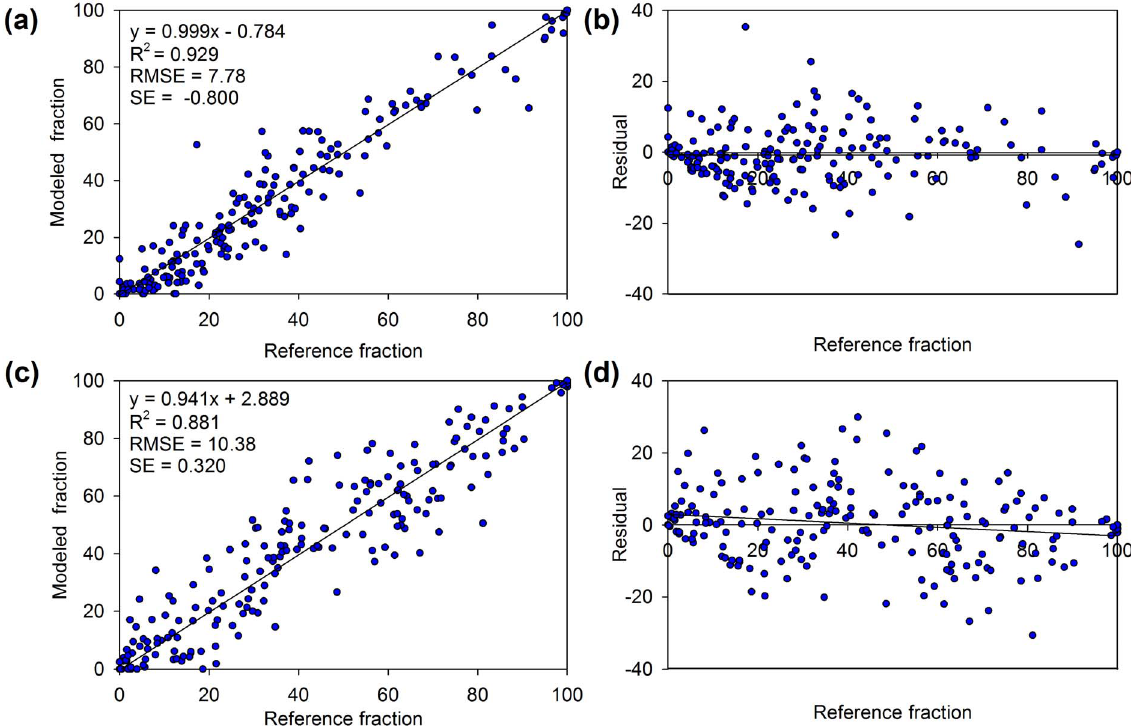
Figure 4. Comparisons between the reference and modeled fractions. ( a ) Vegetation fraction scatter plot for 2010, ( b ) vegetation fraction residuals for 2010, ( c ) vegetation fraction scatter plot for 2002, and ( d ) vegetation fraction residuals for 2002. Perfect agreement, represented by the 1:1 line, is displayed in the scatter plots. The best-fit line is displayed in the residual plots to indicate the general trends of overestimation and underestimation.